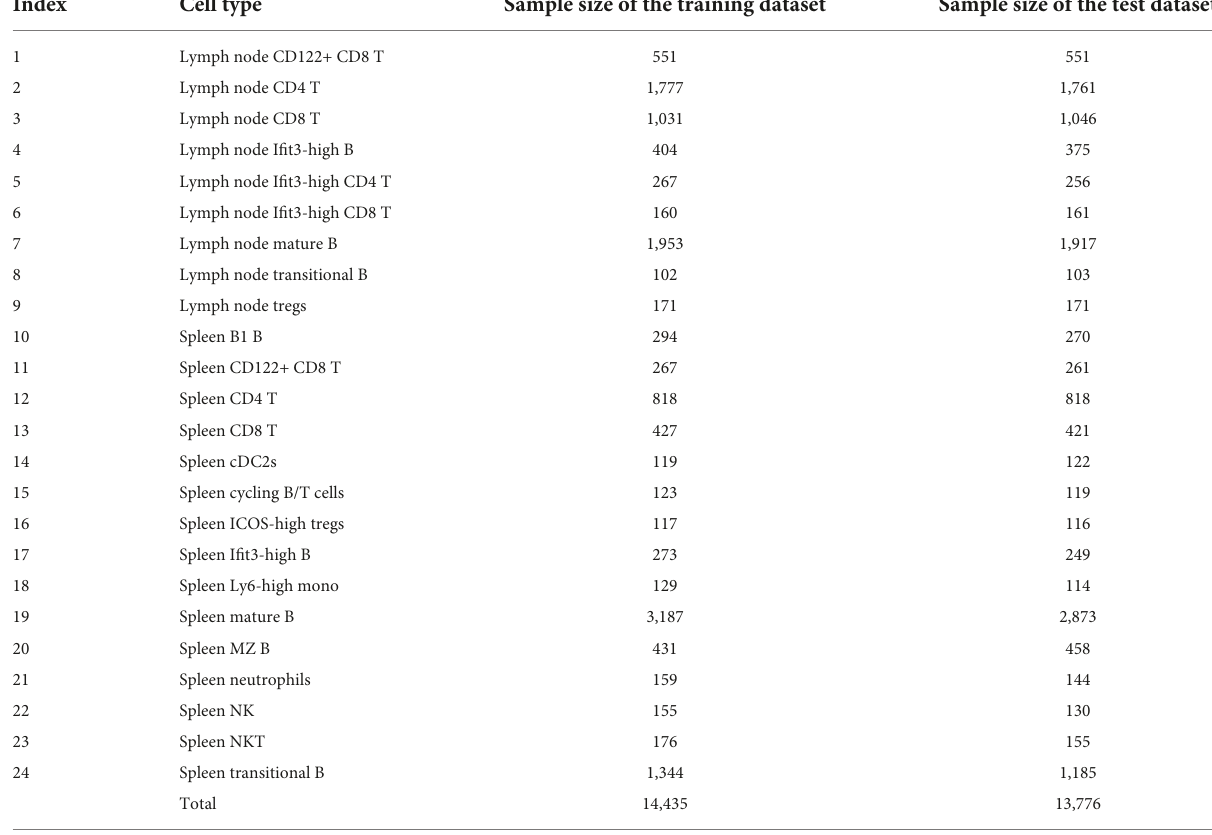
TABLE 1 The sample sizes of each cell type in the training and test